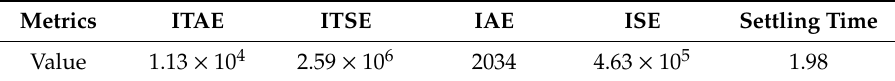
Table 9. Results for the proportional integral (PI) controller.